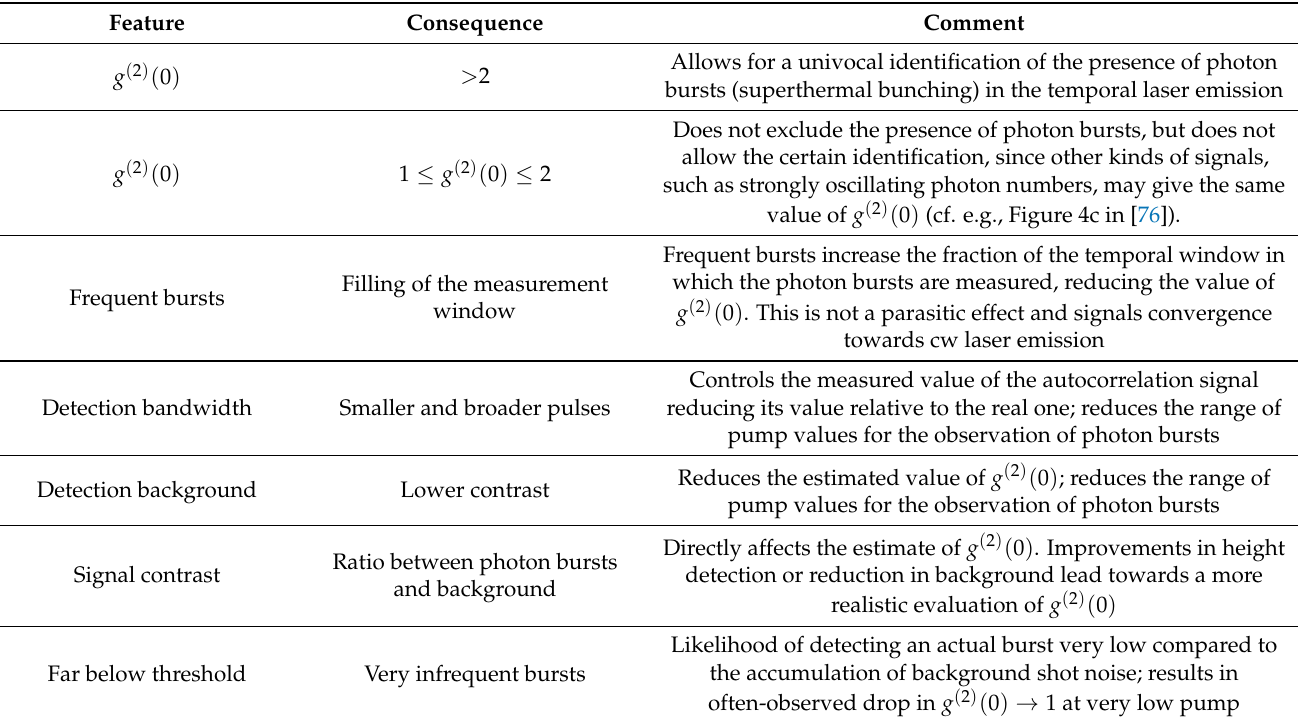
Table 1. Summary of the influence of different factors in the (experimental) identification of photon bursts through g ( 2 ) ( 0 ) .